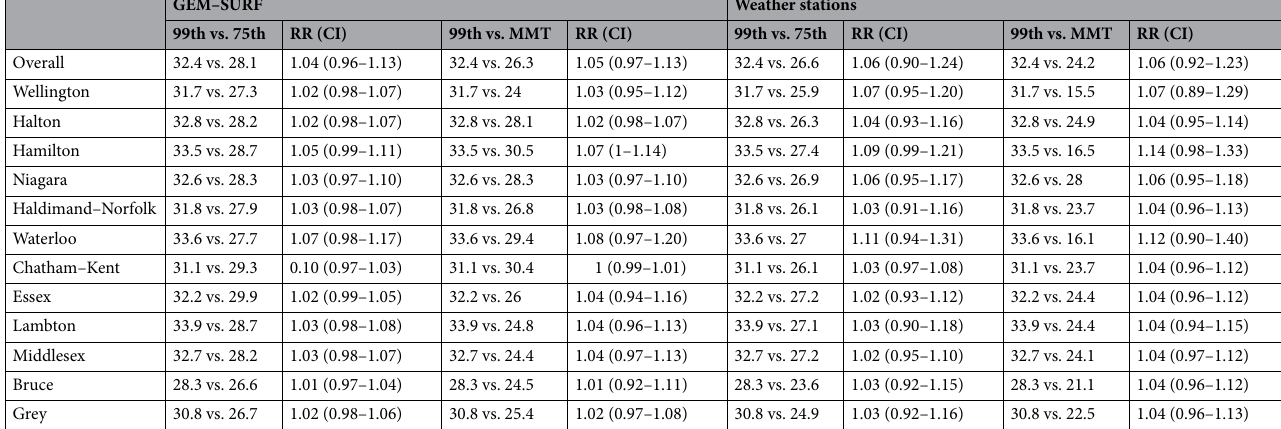
Table 2. Mortality risk estimates at the 99th percentile of weather station daily maximum temperature vs. the 75th percentile and vs. the minimum mortality temperature (May–September 2005–2012). Both pooled estimate and results by region are